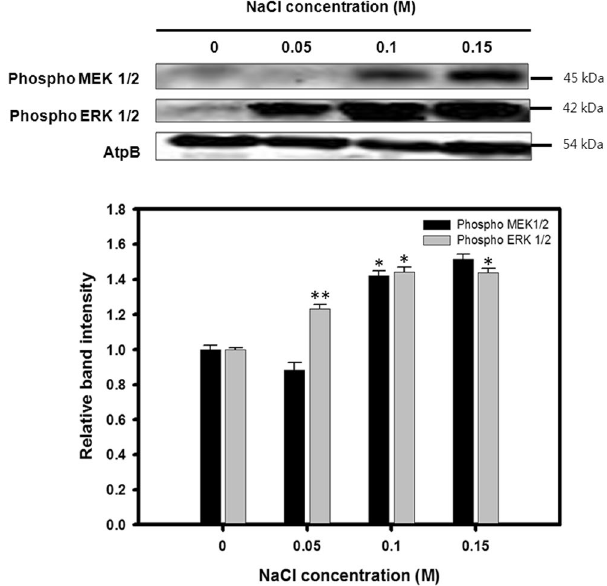
Figure 1. Western blot analysis against anti-MEK1/2 and ERK1/2. ATP β antibody was detected as a loading control. Cell lysates cultivated under 0, 0.05, 0.1, and 0.15 M concentrations of NaCl were analyzed with phospho-specific antibodies to measure the MEK1/2 and ERK1/2 activities. Full-length blots are presented in Supplementary Fig. S6. Relative expression of proteins is represented as mean ± SD (n = 3). Significant differences were determined by Student’s t-test and indicated by asterisks ( * P < 0.05, ** P < 0.01, *** P <